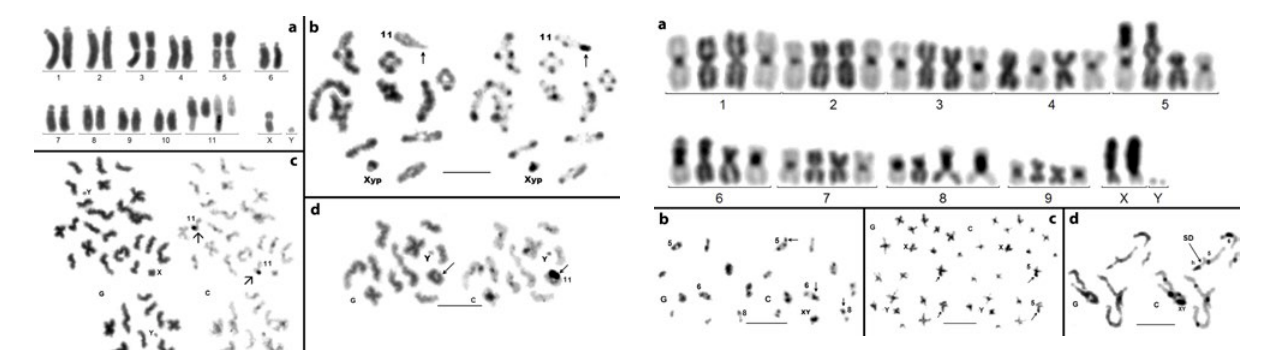
Fig. 2. Sequentially Giemsa stained (G) and C-banded (C) chromo- somes of Stephanorrhina princeps a) Giemsa stained (center) and C-banded karyotype of a spermatogonium exhibiting additional heterochromatin on one chromosome of pairs 5, 6, 8 and on the X. Only heterochromatin of chromosome 5 is clearly separated from the centromere region. b) Diakinesis/metaphase I: heterochromatin (arrows) remains opposite to chiasmata. c) Exceptionally, in each of these 2 brother spermatocytes II, chromosome 5 is asymmetrically carrier of heterochromatin. d) Spermatocyte I at pachynema: synap- sis defect (SD) of the proximal (euchromatic) part of the short arm of bivalent